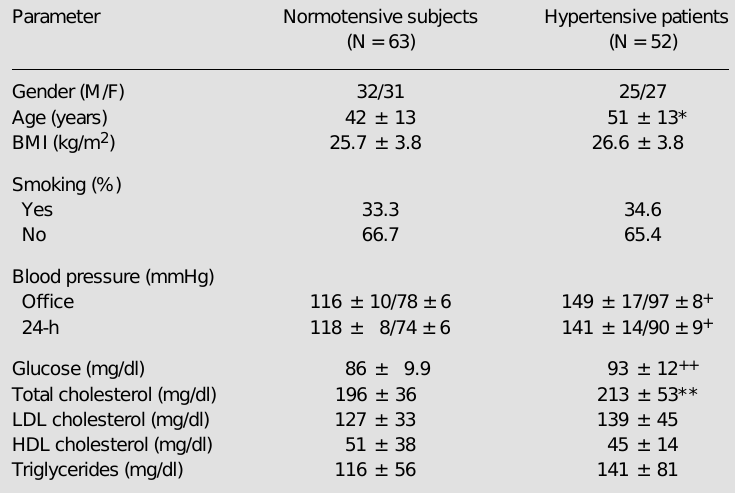
Table 1 - Clinical parameters of the study groups. Values are reported as mean ± SD or percentage of subjects. *P<0.001 vs normoten- sives; + P<0.0001 vs normotensives (Student t -test). **P<0.05 vs normotensives; ++ P<0.05 vs normotensives (Student t